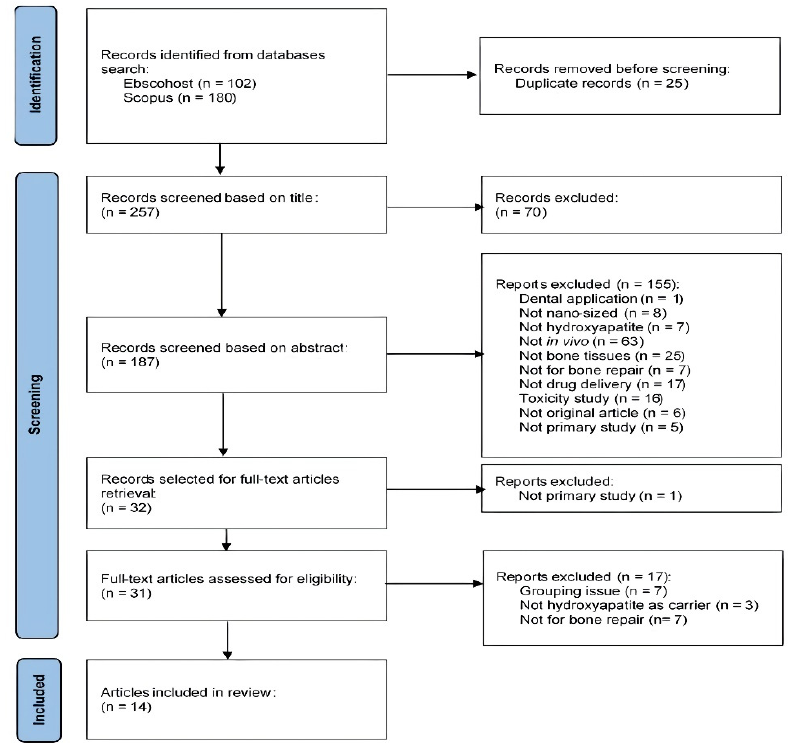
Figure 1. Flowchart for the identification and selection of studies according to the PRISMA statement.